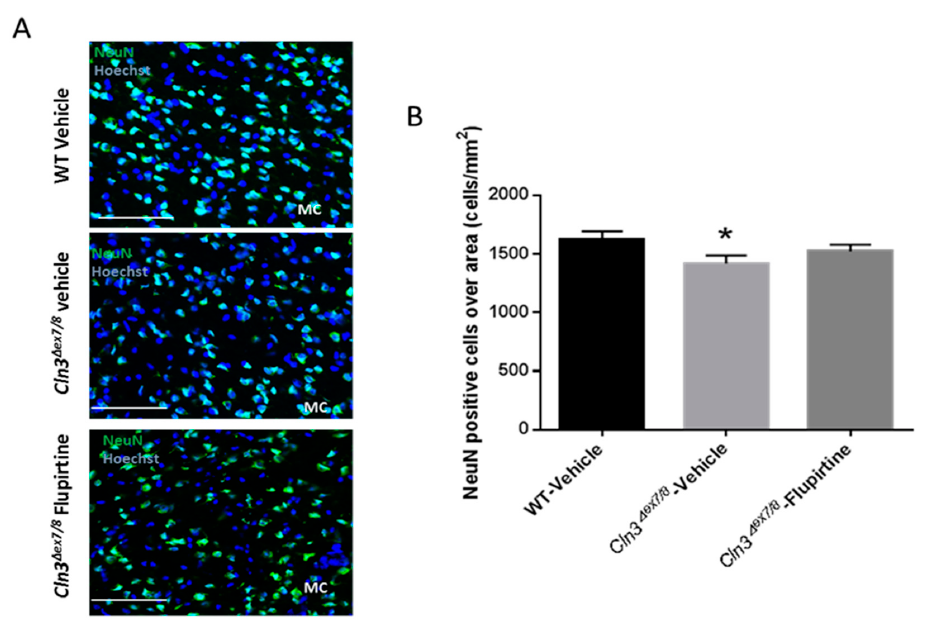
Figure 8. Effect of flupirtine treatment on motor cortex neuron numbers in Cln3 Δ ex7/8 mice. ( A ) Representative images of primary motor cortex from vehicle-treated WT, vehicle-treated Cln3 Δ ex7/8 and flupirtine-treated Cln3 Δ ex7/8 male mice stained with NeuN (mature neuronal marker) in green and counterstained with Hoechst in blue ( n = 4; Scale bars = 50 μ m).; ( B ) NeuN-positive cells normalized to area in the primary motor cortex (MC) of vehicle-treated WT, vehicle-treated Cln3 Δ ex7/8 , and flupirtine-treated Cln3 Δ ex7/8 male mice. Data are expressed as mean ± SEM. * p < 0.05 compared to vehicle-treated WT.